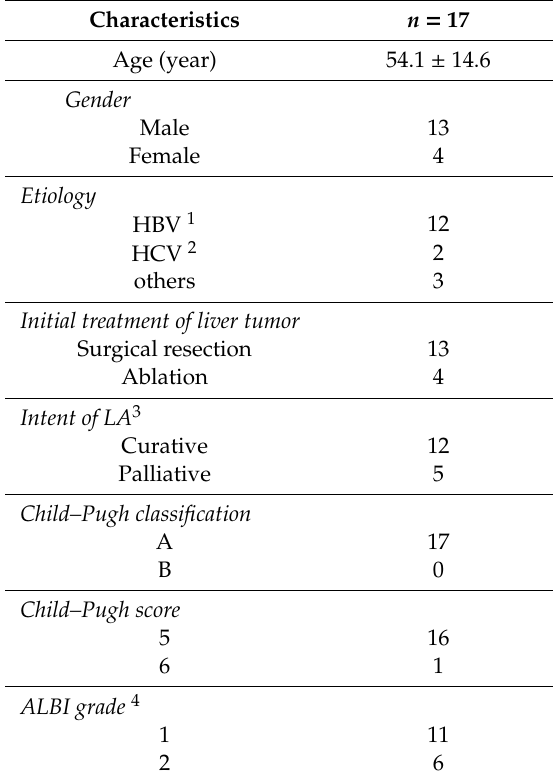
Table 1. Baseline characteristics of the